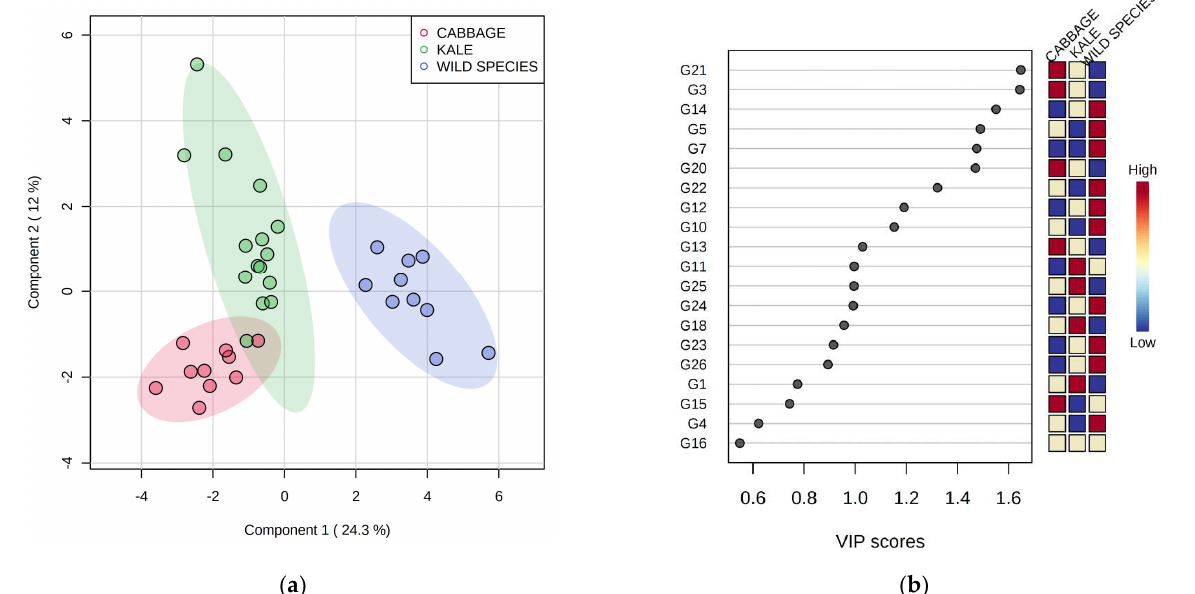
Figure 4. ( a ) Differentiation of Brassicaceae species in two-dimensional space by partial least squares−discriminant analysis (PLS−DA); ( b ) variable importance in projection (VIP) scores of volatile compounds (variables) generated in the glucosinolate (GSL) pathway most useful for the differentiation. Codes indicating compounds correspond to those reported in Table 1.